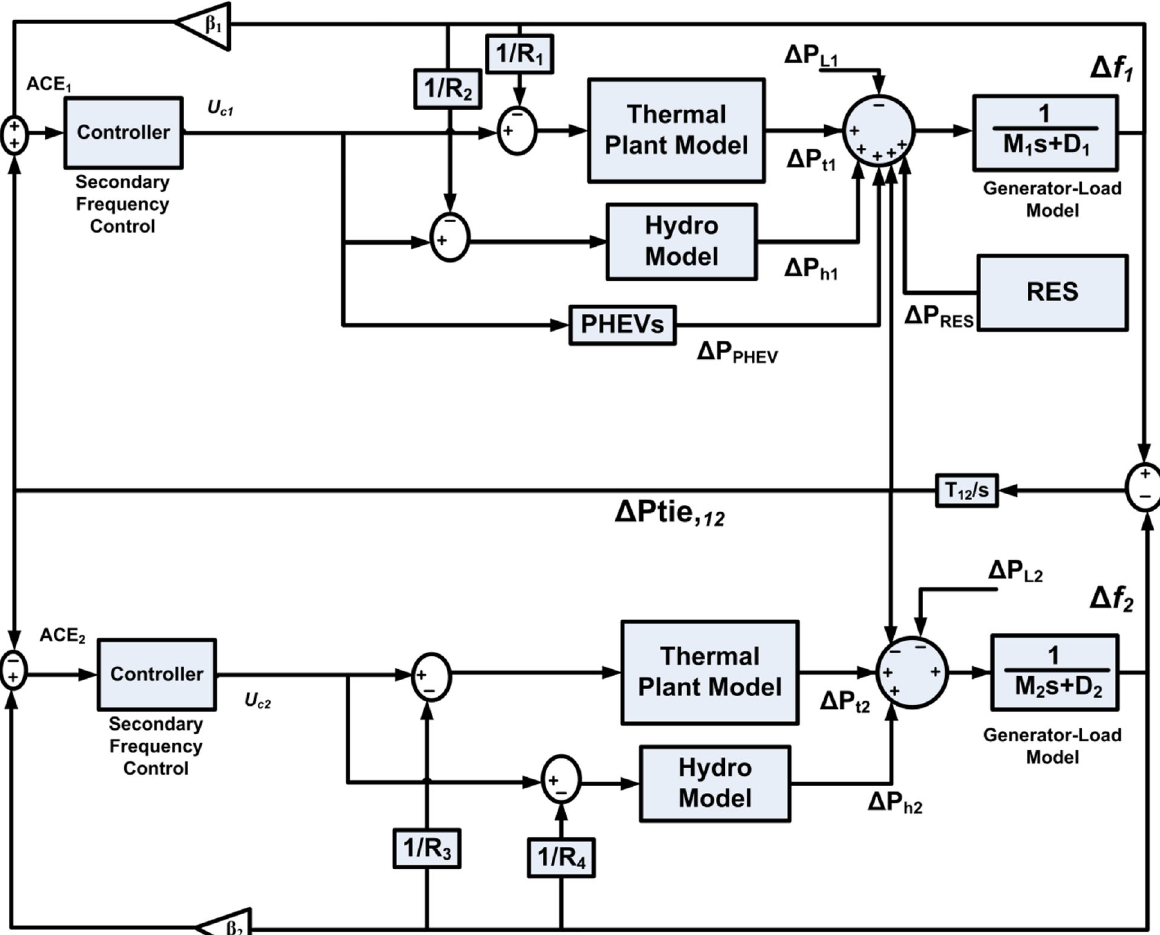
Fig. 1 Two-area power system